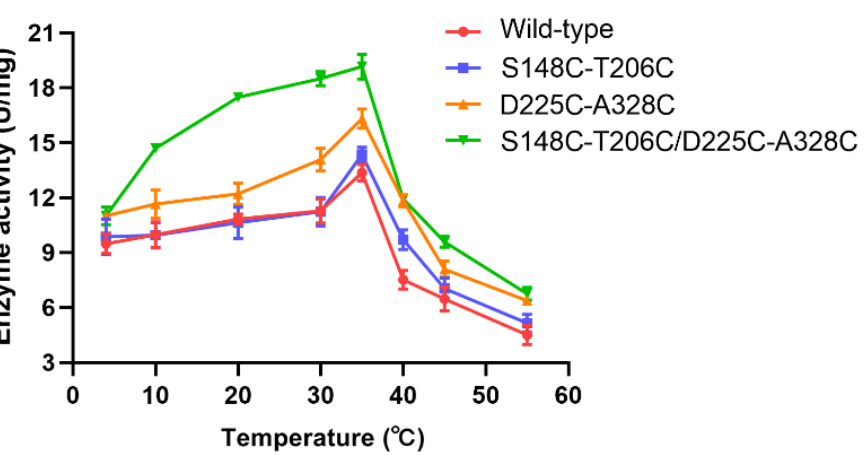
Figure 1. Thermoactivity of wild-type MsPLD and various mutants. Effect of temperature on the hydrolysis activity of wild-type MsPLD and mutants S148C-T206C, D225C-A328C and S148C- T206C/D225C-A328C.